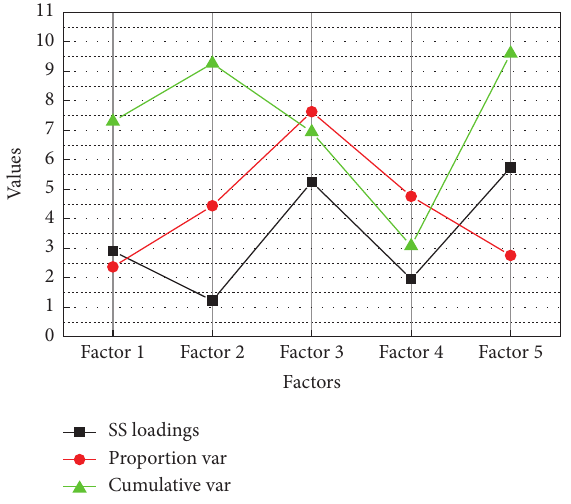
Figure 8: Variance contribution